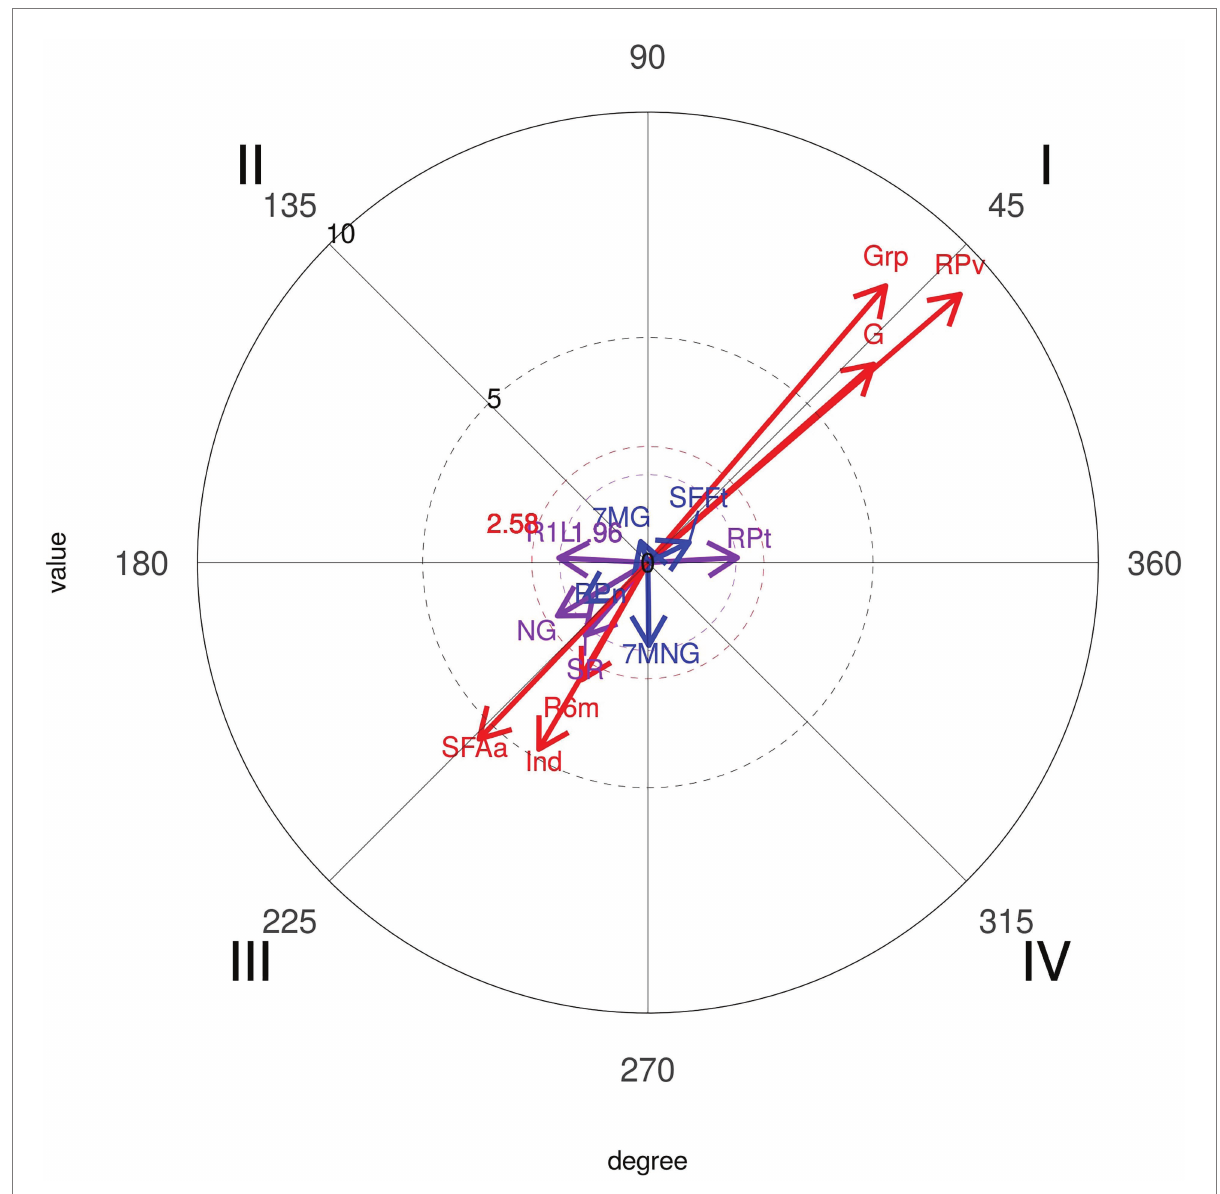
FIGURE 13 Polar coordinate analysis map: focal conduct “Portugal National Team.” Conditioned conducts: Grp, group tactical mean; Ind, individual tactical mean; RPv, pivot shot; RPt, wing shot; R1L, 9 m shot; R6m, 6 m shot; SR, no shot; G, goal; NG, no goal; SFAa, no shot by opponent